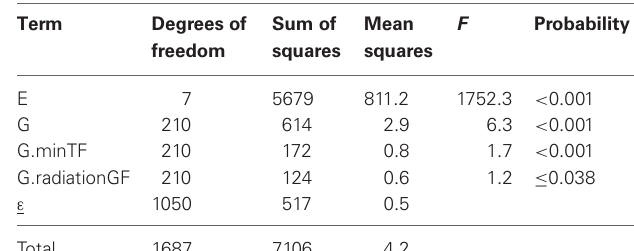
regression model (model 6) to CIMMYT maize stress